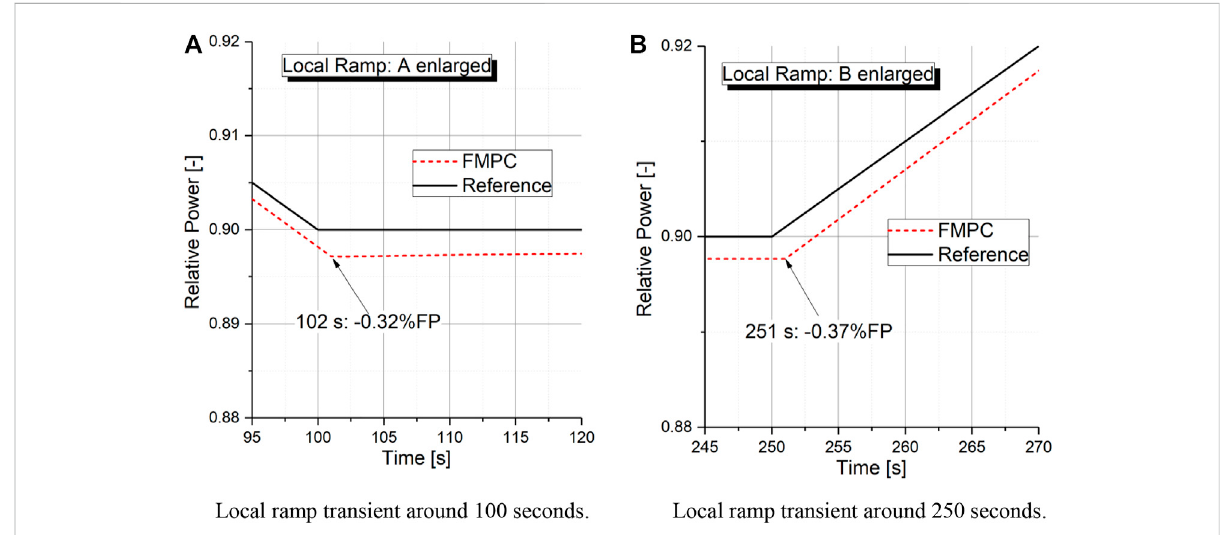
Enlarged view of the area A and B for the local ramp transient. (A) Local ramp transient around 100 s. (B) Local ramp transient around 250 s.